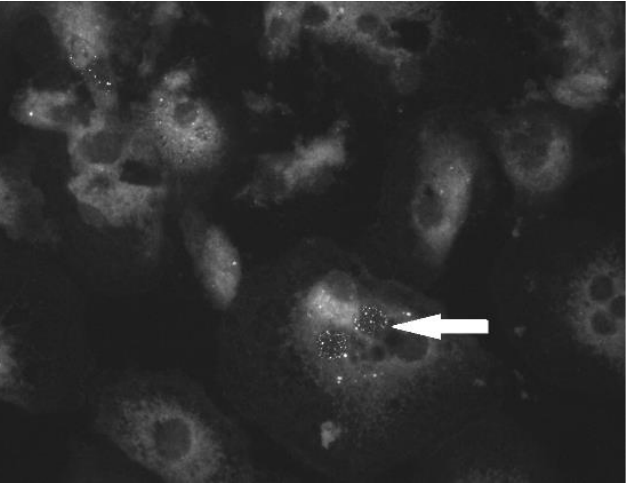
Figure 2. Indirect immunofluorescence assay: PaBV-4-infected embryonic cockatiel brain cells with granules in the nuclei (white arrow).